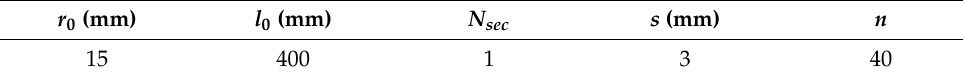
Table 1. Characteristics of the muscles utilized to build the